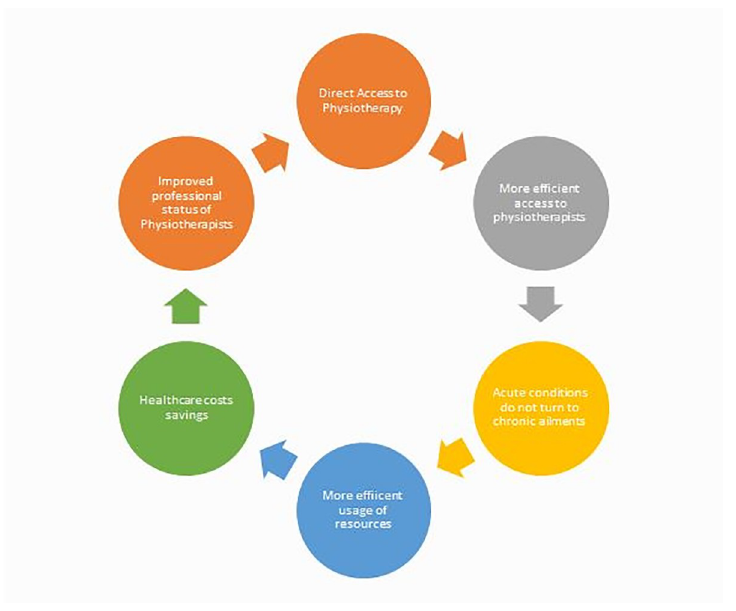
Fig 1. Benefits of direct